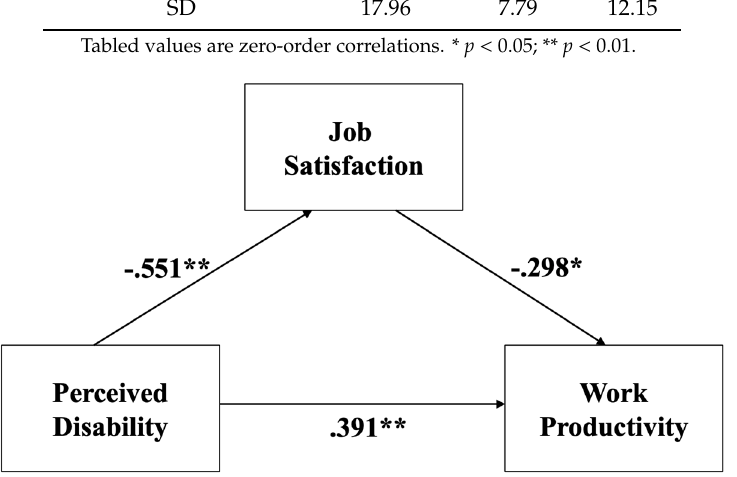
Figure 1. The model with standardized regression coefficients depicting job satisfaction as a mediator in the relation between perceived disability and work productivity. Note. The analysisincludes age, sex, and education level as covariates modeled as exogenous variables. * p < 0.05; ** p < 0.01. Table 2. Correlation Matrix, Means, and Standard Deviations of Study Measures.